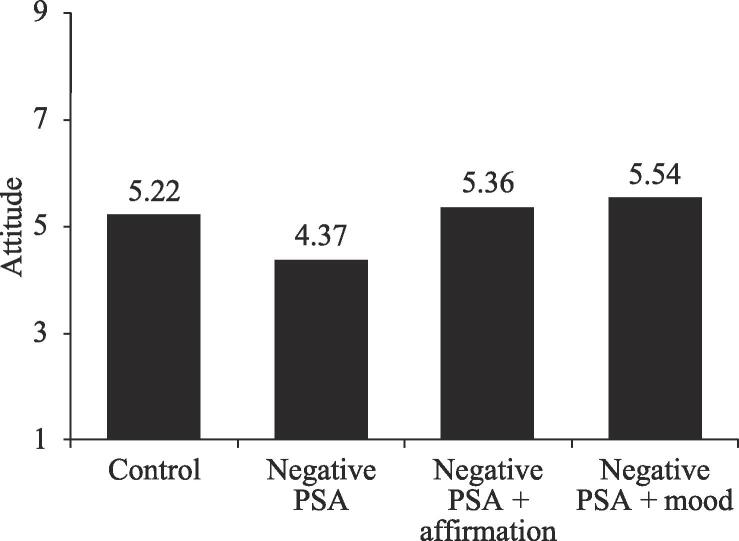
Message acceptance -- attitude, Study 1.